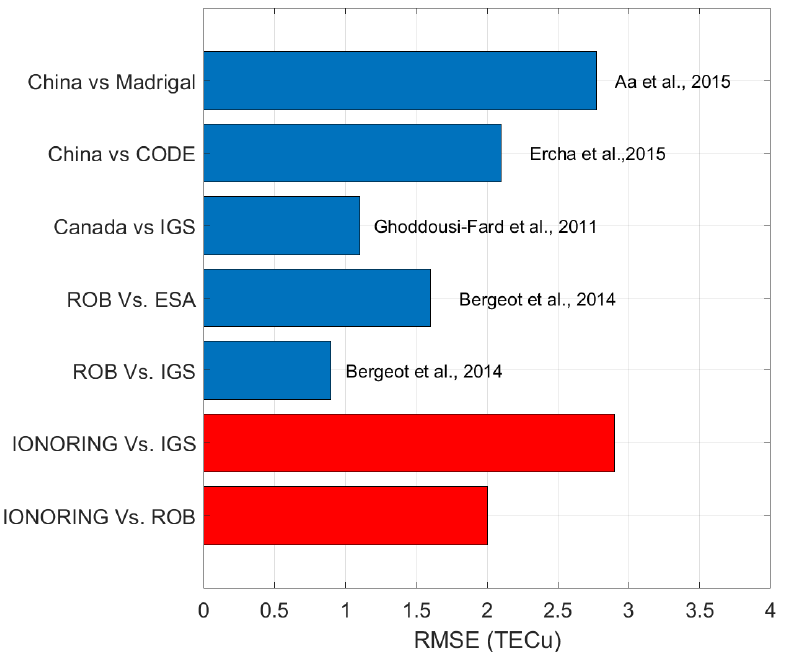
Figure 5. Root Mean Square Error resulting from the validation of different TEC mapping techniques. In red, the results reported in this paper (Figure 3 and Figure 4).